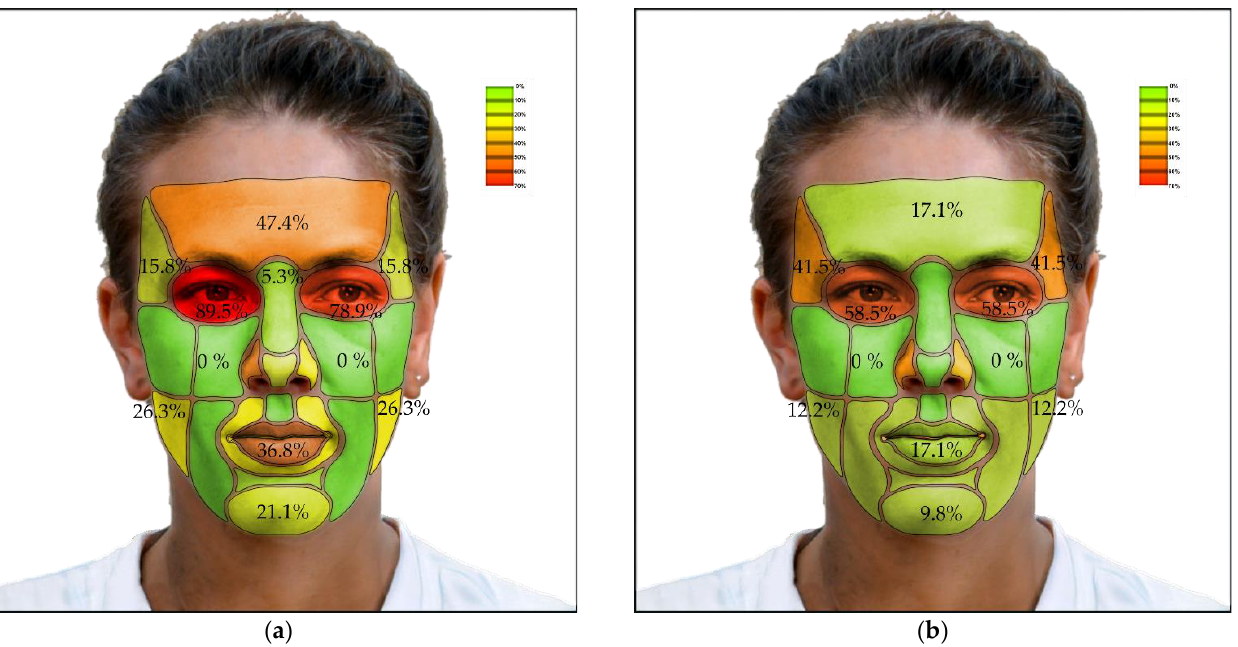
Figure 4. The percentage of deviation in TrueDepth scans from CBCT scans: ( a ) Results in men; ( b ) Results in women.